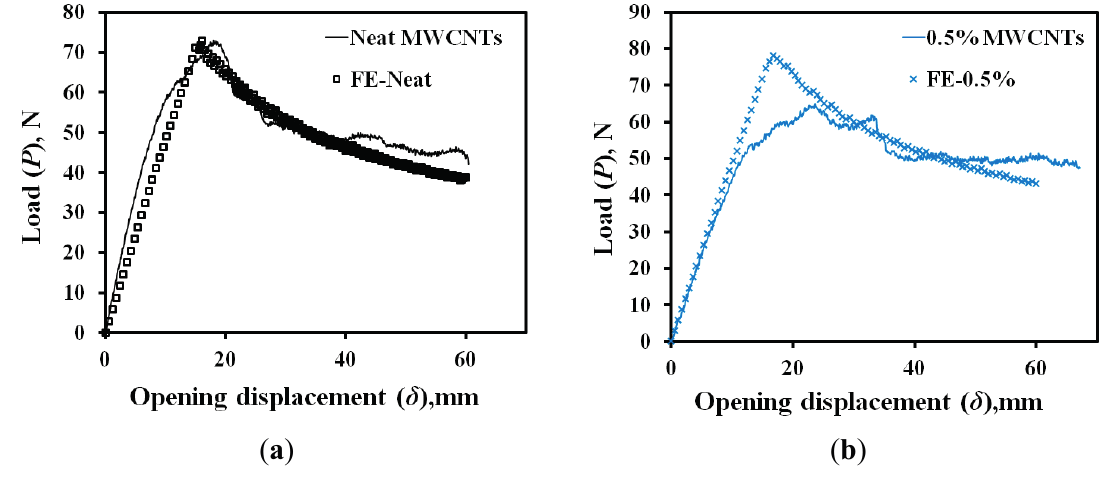
Figure 18. Comparison between the experimental and numerical load-displacement responses for unidirectional CFRP composites containing ( a ) neat and ( b ) 0.5 wt%